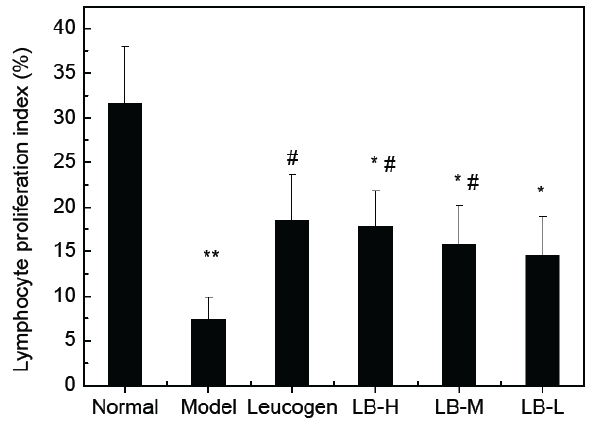
Figure 2. The effects of lingonberry anthocyanins on spleen cell proliferation of radiation in mice (mean ± S.D, n = 10) ( ** p < 0.01, * p < 0.05 vs. Normal; # p < 0.05 vs.